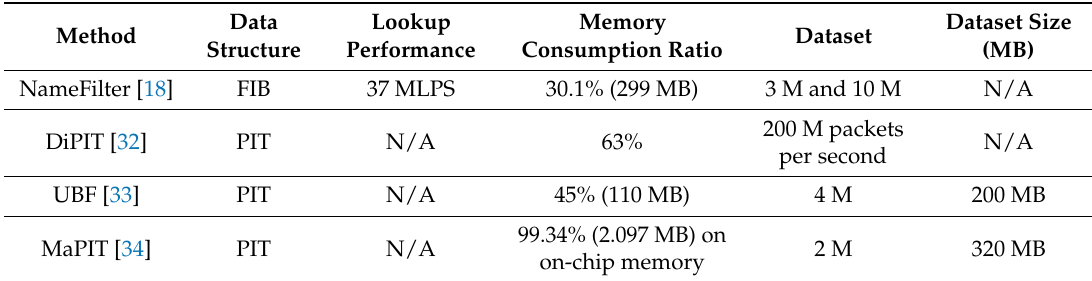
Table 3. Comparison of lookup throughput based on BF schemes.